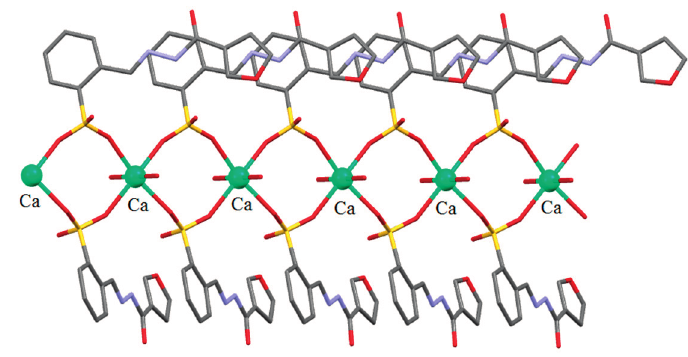
Figure 2. The section of the coordination polymer 1. Symmetry code: A: – x + 1, – y , z ; C: – x + 1, – y , z + 1; D: x , y , z + 1.